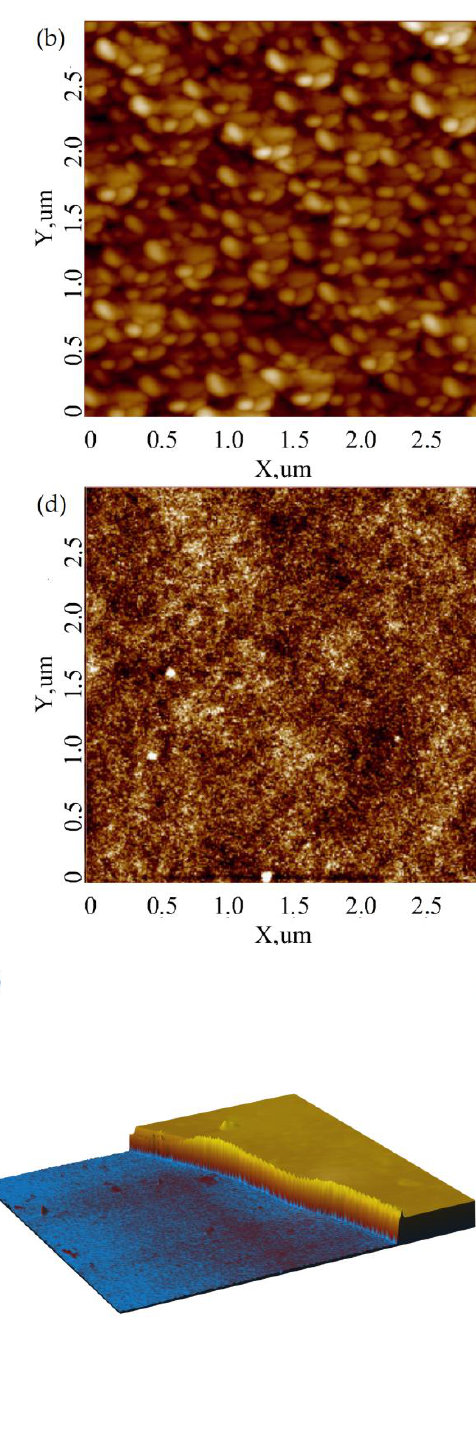
Figure 2. AFM image of the surface of ( a ) the lower PDPh layer; ( b ) the Cu 2 O oxide layer; ( c ) the copper electrode; ( d ) the upper PDPh layer; ( e , f ) the surface topography and 3D image of the lower polymer layer with a slice section.